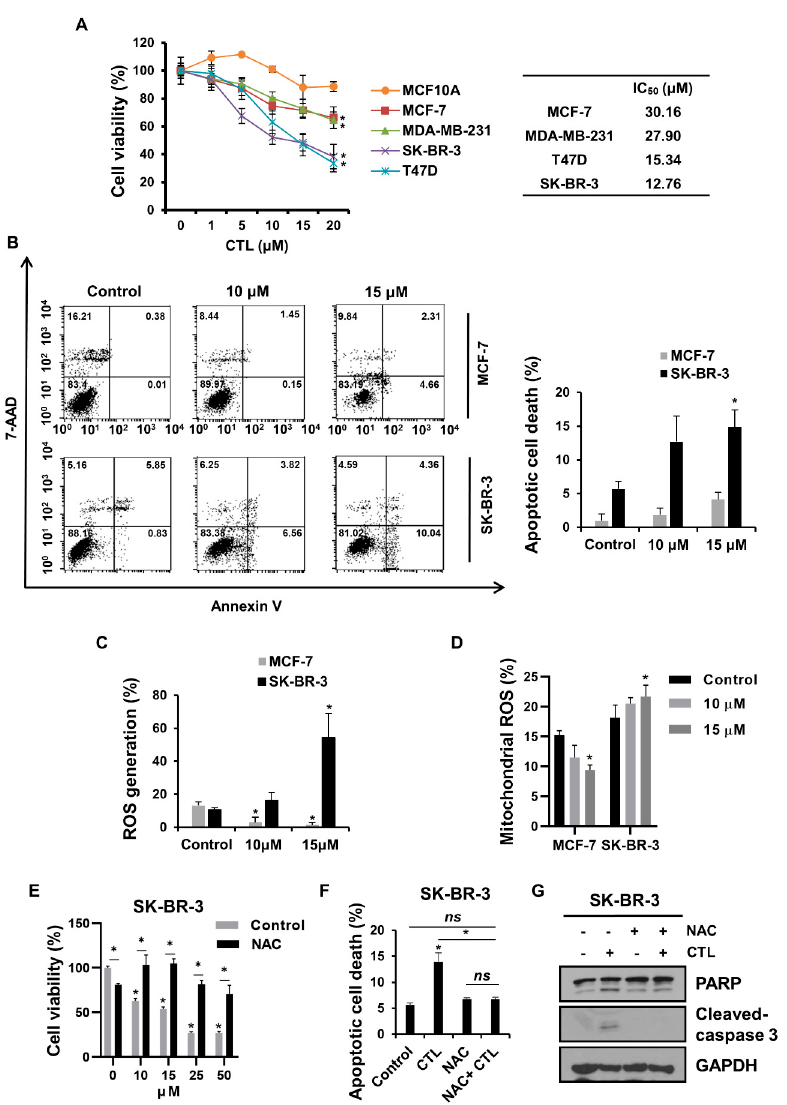
(Figure 1E,F). The strong rescuing effect of NAC on CTL-induced apoptosis was confirmed by western blot analysis that the increased levels of apoptotic markers such as cleaved- PARP and -caspase 3 by CTL treatment were blocked by NAC pre-treatment in SK-BR-3 (Fig- by NAC pre-treatment in SK-BR-3 (Figure 1G). Taken together, our results demonstrate ure 1G). Taken together, our results demonstrate that CTL induces apoptotic cell death to a that CTL induces apoptotic cell death to a different degree in breast cancer cells, and the different degree in breast cancer cells, and the sensitivity is correlated with CTL-induced sensitivity is correlated with CTL-induced ROS production. ROS production.